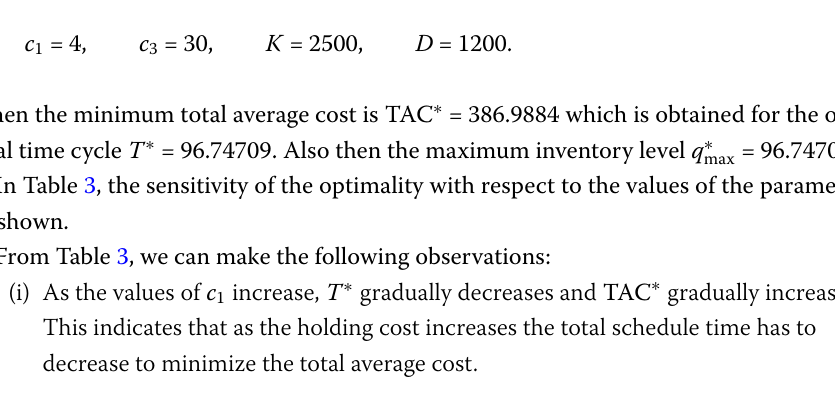
Table 3 Sensitivity table for case Model 1 Parameters Change in